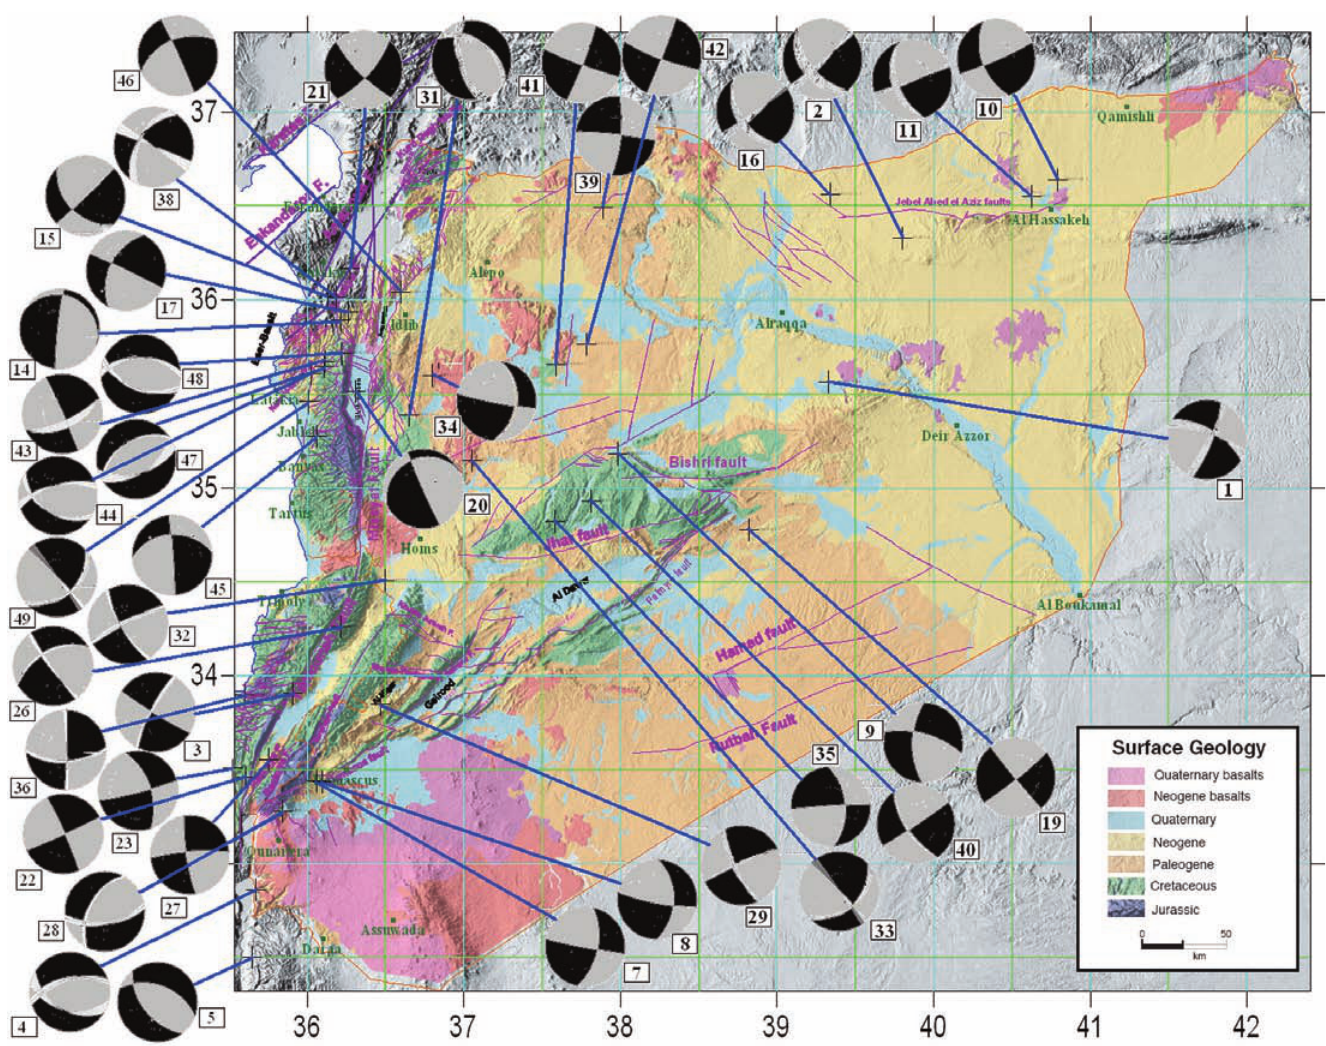
Figure 4. The focal mechanisms of the main events recorded over the last ten years in Syria and its nearby regions. The adjacent numbers indicate the event numbers in Appendix 1. The fault plane solutions are presented with lower-hemisphere, equal-area projections: white quadrants for dilatation, and black for compression. The base map showing the surface geology was modified by Brew et al. [2001], from Dubertret [1955], Ponikarov [1966] and Devyatkin et al.